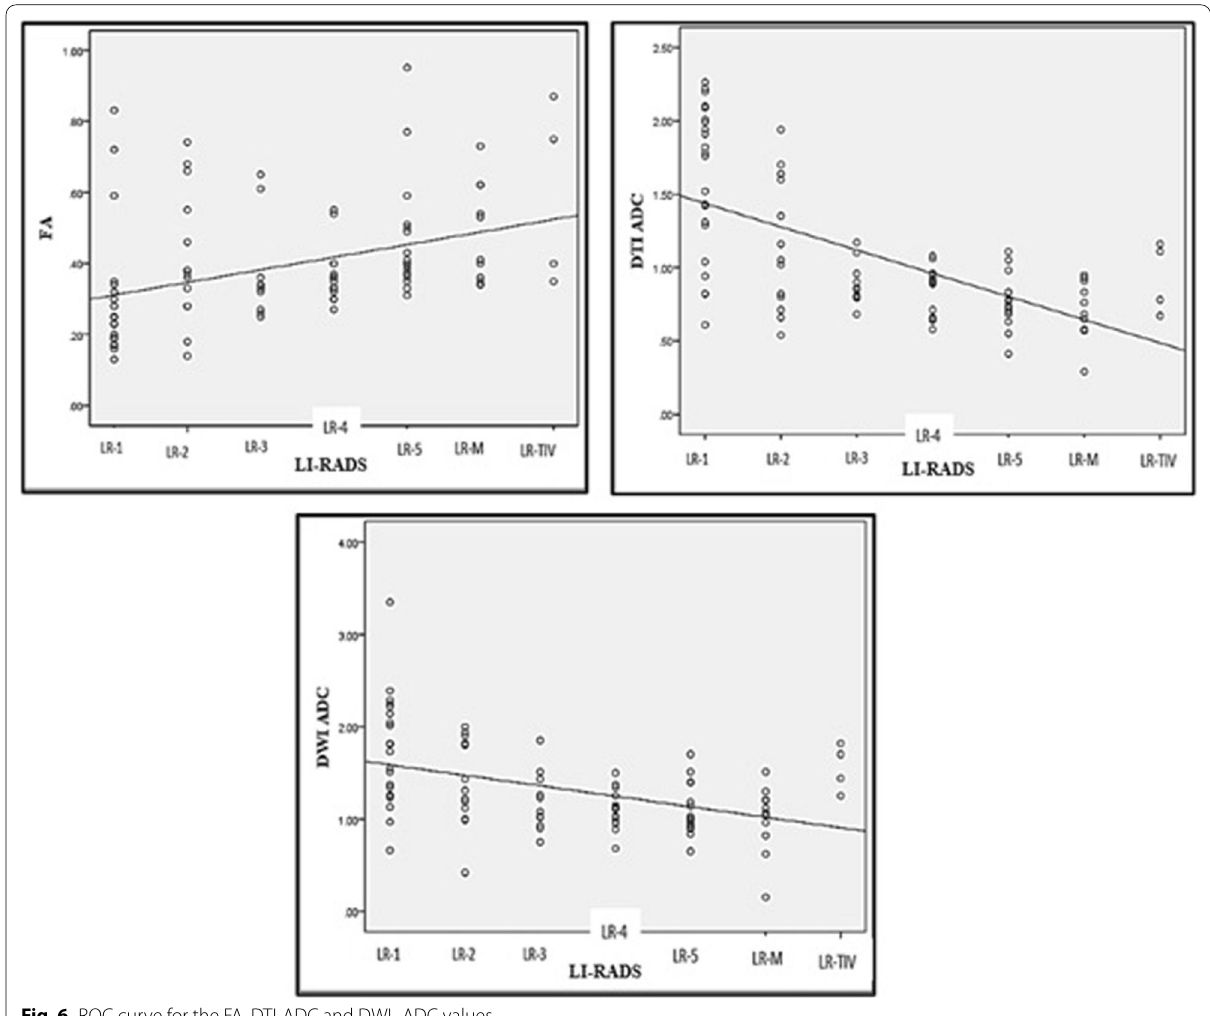
Fig. 6 ROC curve for the FA, DTI-ADC and DWI -ADC values